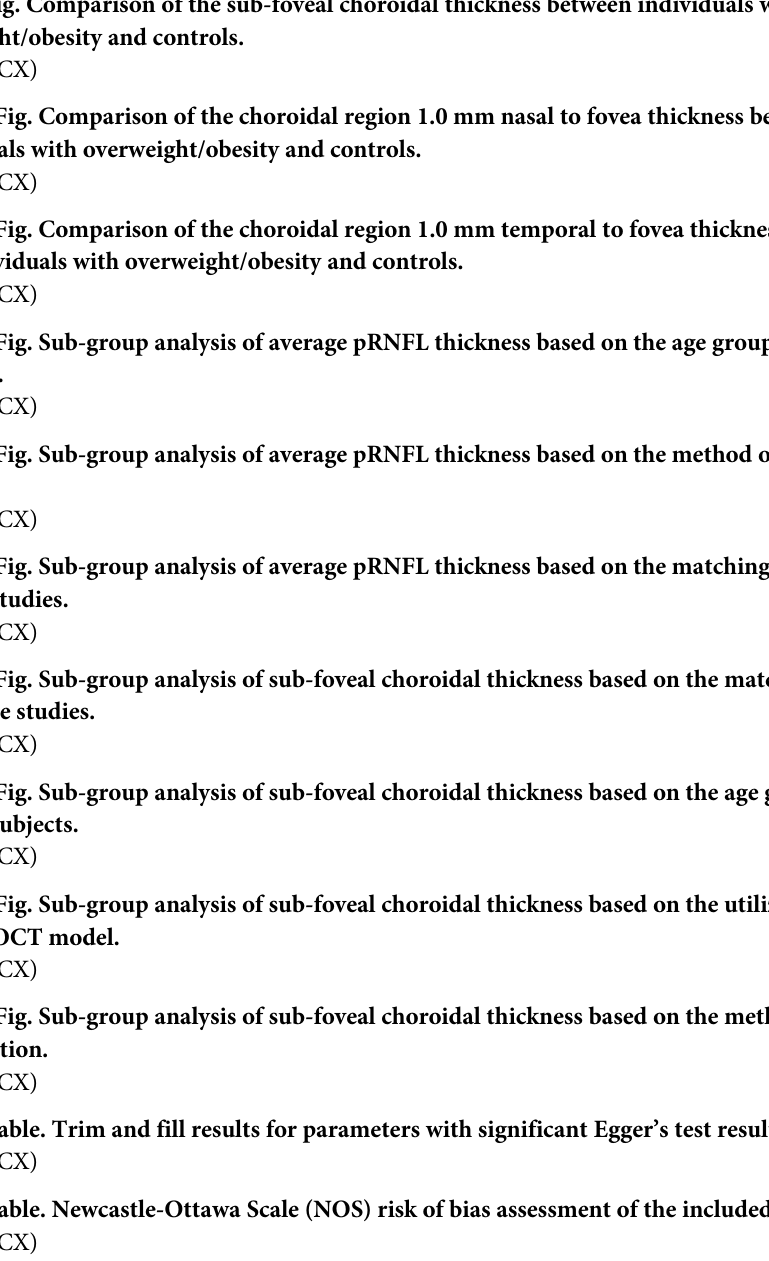
S8 Fig. Comparison of average choroidal thickness between individuals with overweight/ obesity and controls. S9 Fig. Comparison of the sub-foveal choroidal thickness between individuals with over- weight/obesity and controls. S10 Fig. Comparison of the choroidal region 1.0 mm nasal to fovea thickness between indi- viduals with overweight/obesity and controls. S11 Fig. Comparison of the choroidal region 1.0 mm temporal to fovea thickness between individuals with overweight/obesity and controls. S12 Fig. Sub-group analysis of average pRNFL thickness based on the age group of the sub- jects. S13 Fig. Sub-group analysis of average pRNFL thickness based on the method of eye selec- tion. S14 Fig. Sub-group analysis of average pRNFL thickness based on the matching status of the studies. S15 Fig. Sub-group analysis of sub-foveal choroidal thickness based on the matching status of the studies. S16 Fig. Sub-group analysis of sub-foveal choroidal thickness based on the age group of the subjects. S17 Fig. Sub-group analysis of sub-foveal choroidal thickness based on the utilized SD-OCT model. S18 Fig. Sub-group analysis of sub-foveal choroidal thickness based on the method of eye selection. S1 Table. Trim and fill results for parameters with significant Egger’s test result. S2 Table. Newcastle-Ottawa Scale (NOS) risk of bias assessment of the included